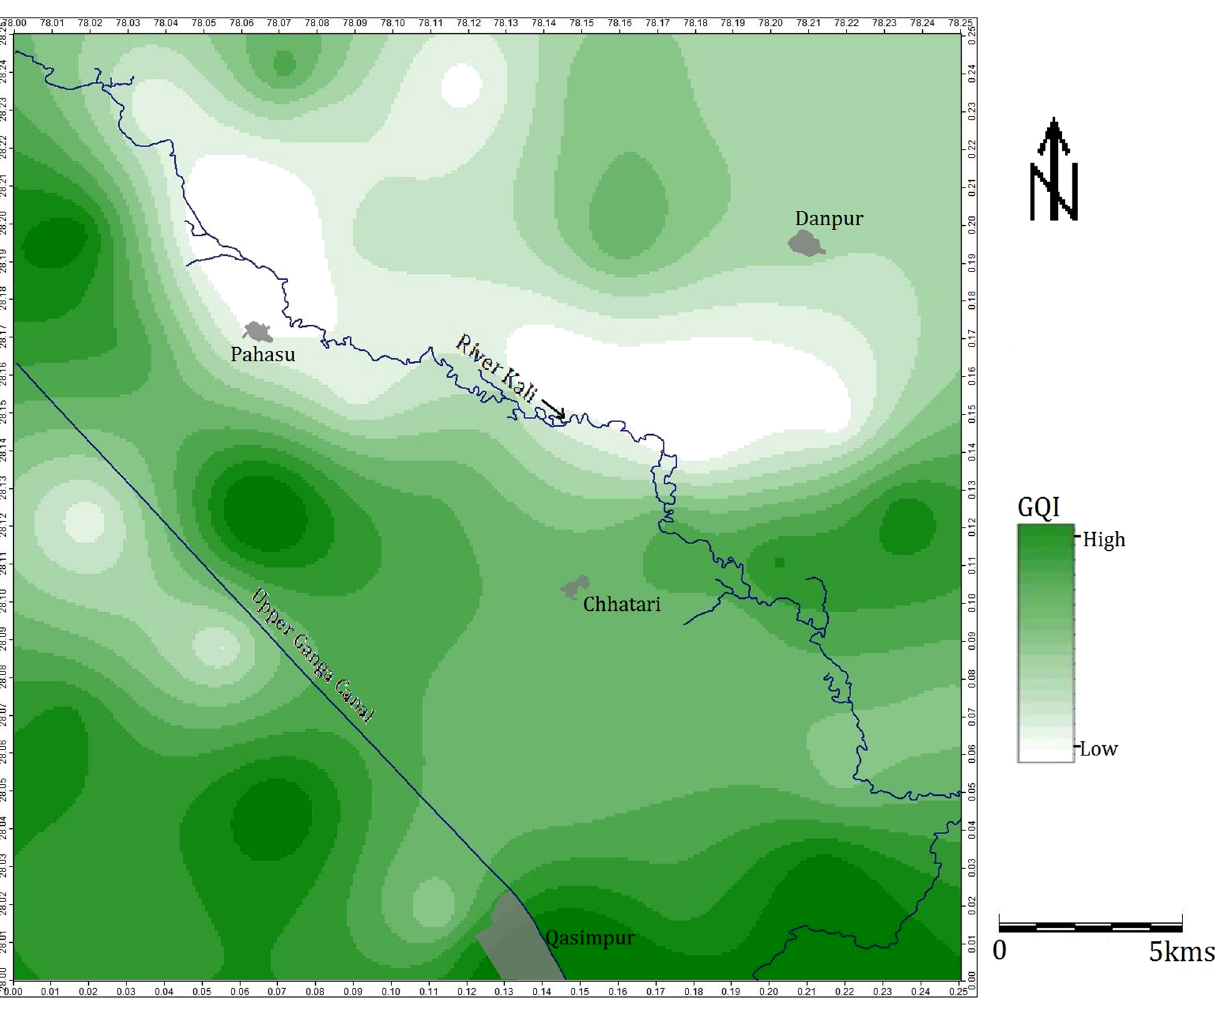
Fig. 5 Groundwater quality index map for post-monsoon